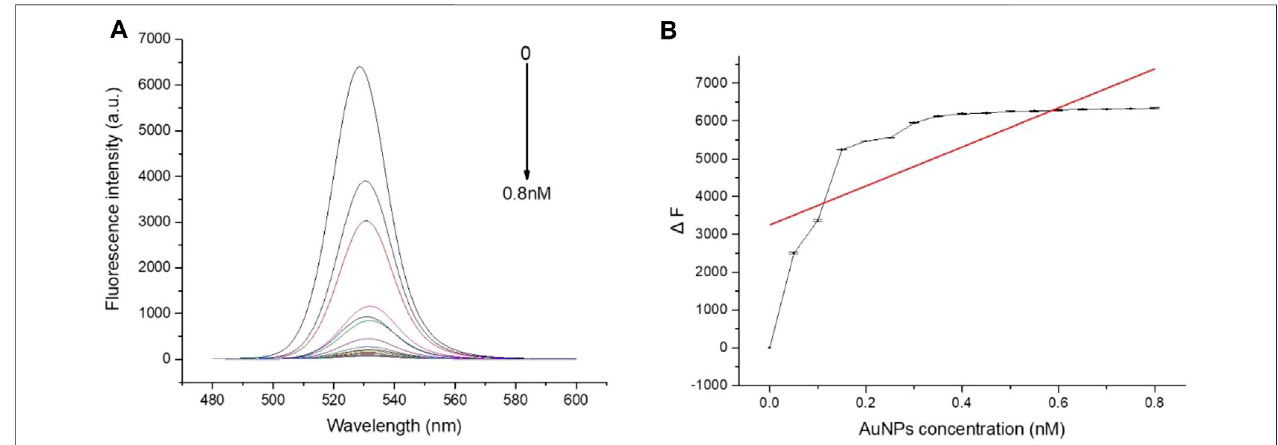
FIGURE5|(A) The fl uorescencespectraofQD-aptamershybridizedwithdifferentconcentrationsofAuNPs-ssRNA; (B) Whenthehybridizationconcentrationratio of QD-aptamers to AuNPs-ssRNA was 10:1, the fl uorescence intensity of QDs reached the plateau stage. The aptamer sensor for the detection of targeted CSC